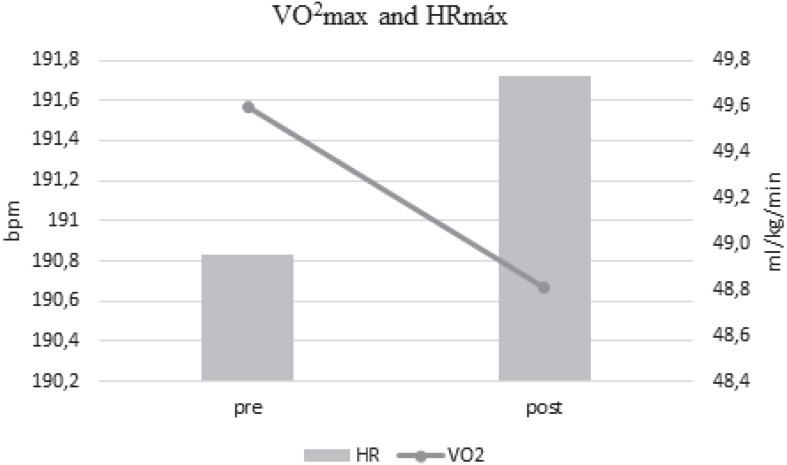
VO2 max and HRmax pre- and post-quarantine.